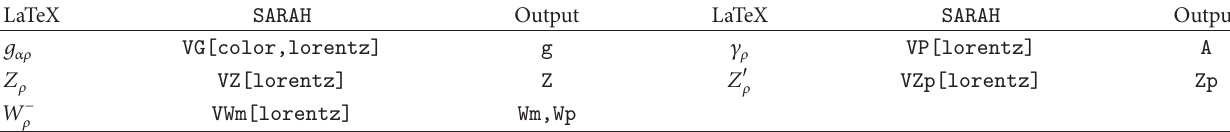
Table 4: Vector bosons in the B-L- SSM after electroweak symmetry breaking.